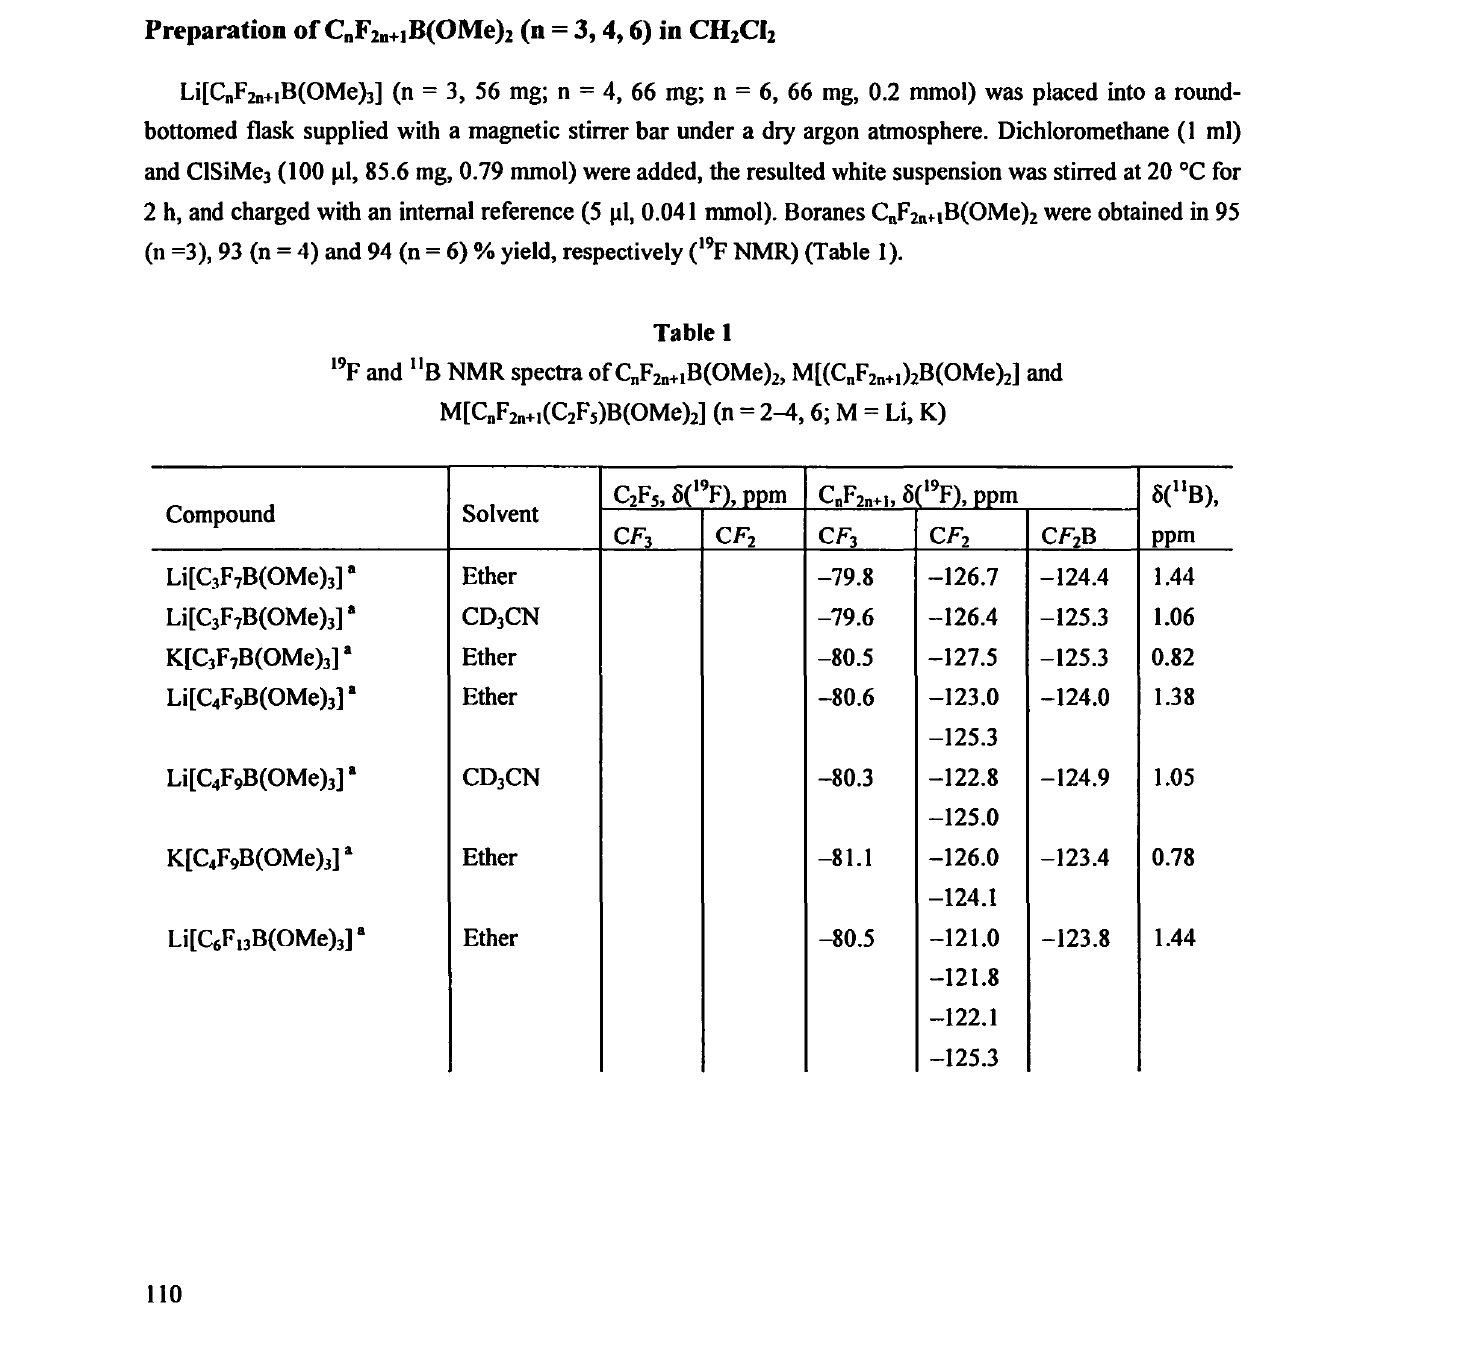
I9 F and U B NMR spectra of C